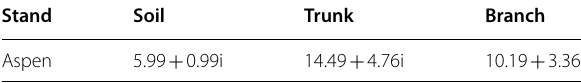
Table 2 The permittivity of soil and canopy layers Stand Soil Trunk